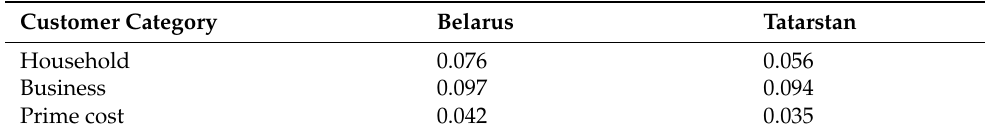
Table 2. Average annual electricity prices in 2020, USD/kWh.